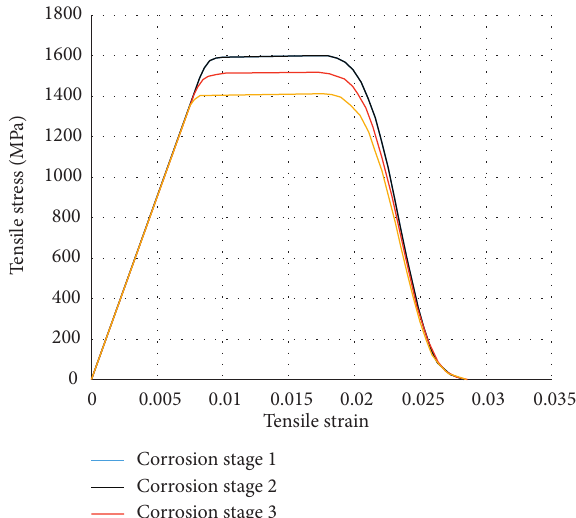
Figure 2: The averaged stress-strain curves of steel wires in dif- ferent corrosion stages considering the length effect and Daniels effect.